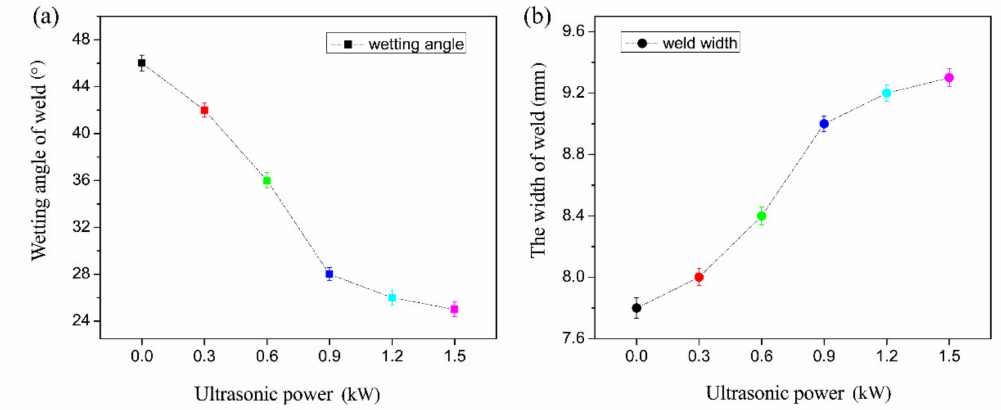
Figure 5. ( a ) The wetting angle and ( b ) width of weld under the assistance of varying ultrasonic